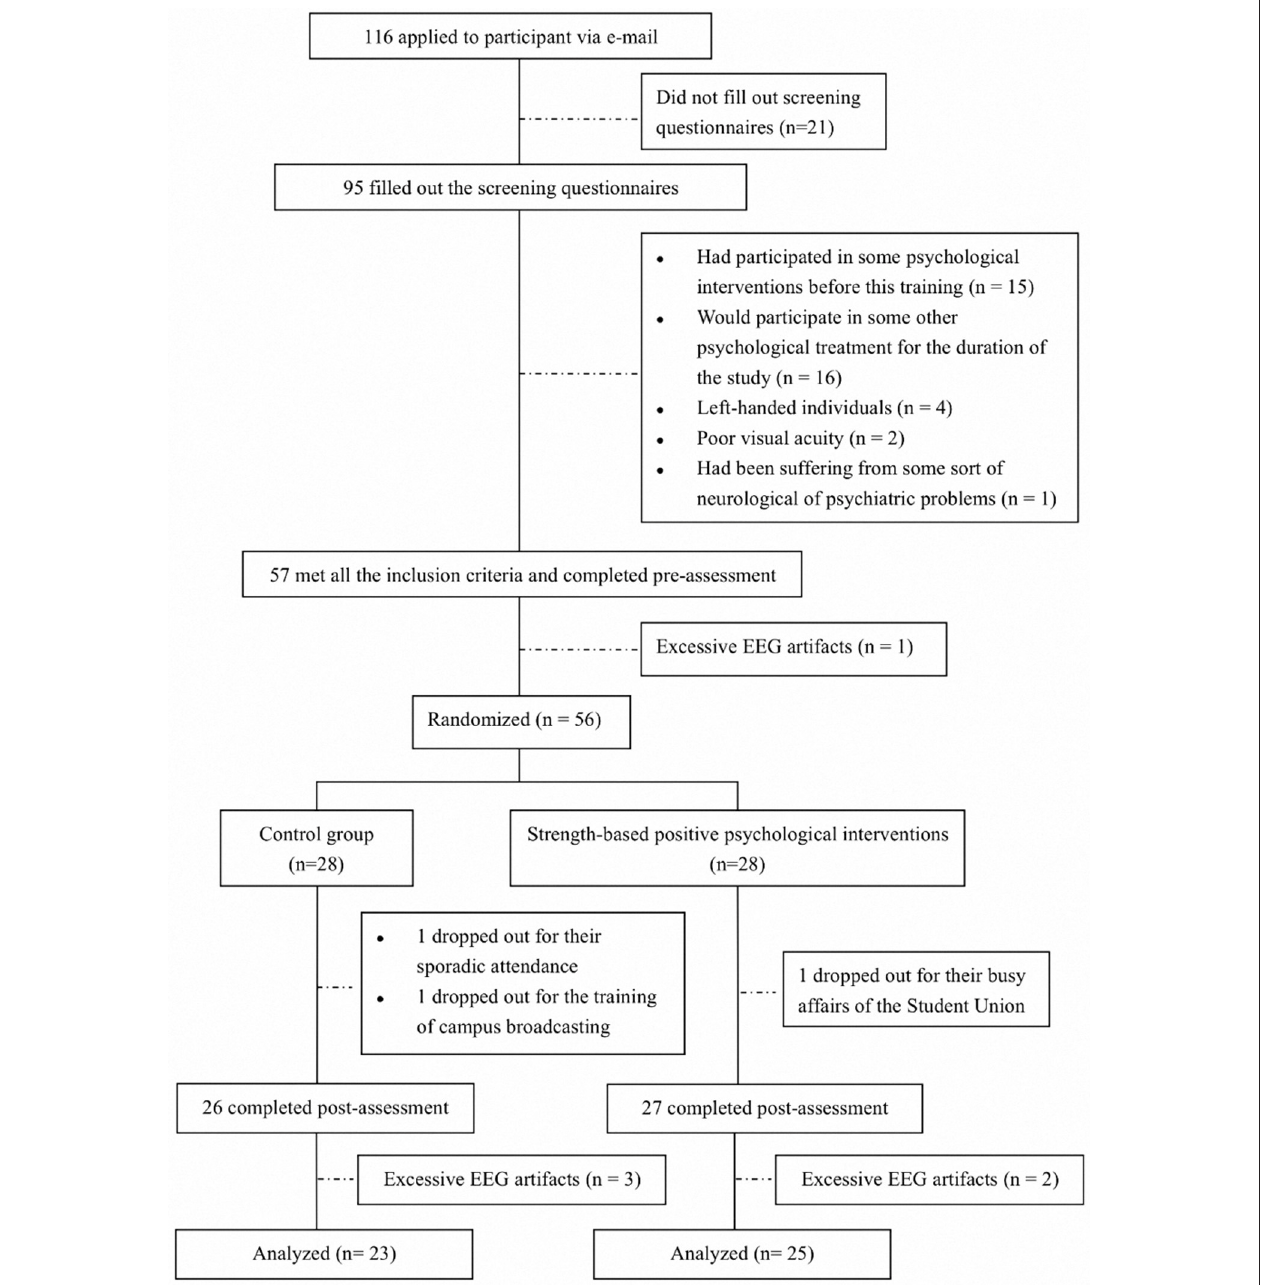
FIGURE 1 | Flow of